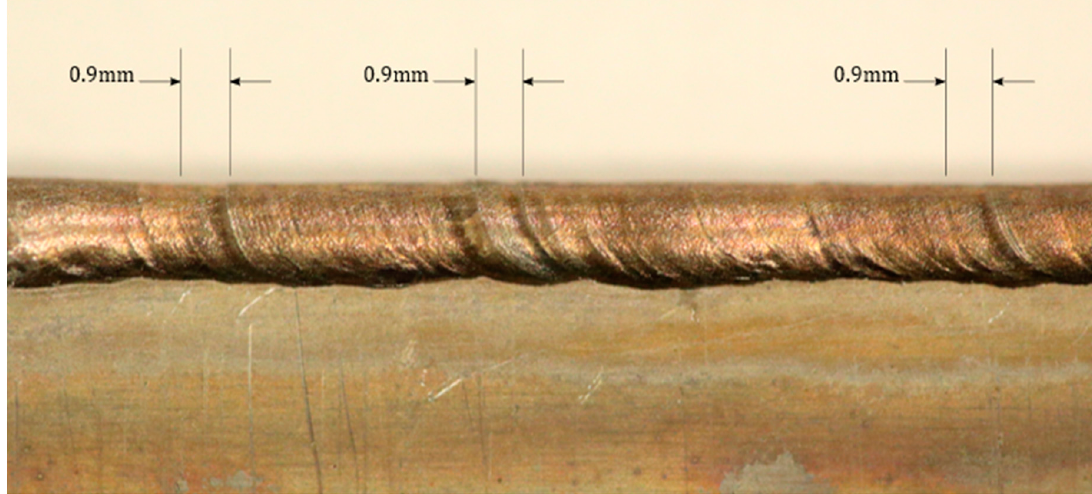
Figure 8. A high-resolution photograph of the blade surrogate showing the detected features from the thermal imaging. thermal